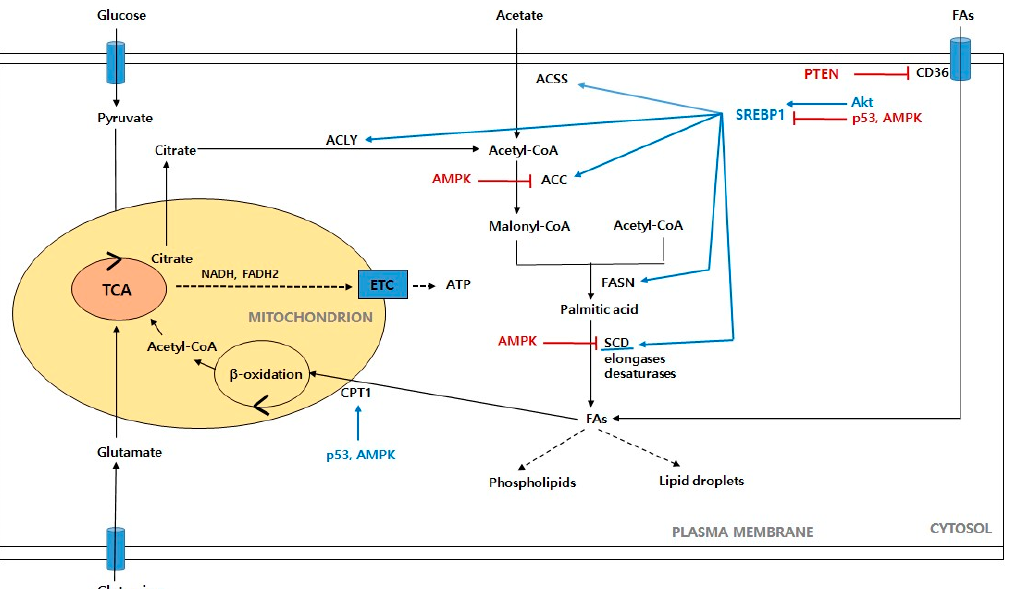
Figure 3. Schematic representation of fatty acid metabolism in cancer cells. Glucose-derived pyruvate enters the mitochondria to form citrate, which then moves to the cytoplasm and contributes to the de novo synthesis of fatty acids. Acetate is also another source of lipogenesis. When cellular fatty acids are in excess, the fatty acids absorbed through CD36 are converted into lipid droplets and are made available when needed. Acetate also provides reducing equivalents, such as NADH and FADH2 through β -oxidation. Finally, ATP is generated from the ETC. Abbreviations: ACSS: acetyl-CoA synthetase; ACLY: ATP citrate lyase; ACC: acetyl-CoA carboxylase; FASN: fatty acid synthase; SCD: stearoyl-CoA desaturase; FAs: fatty acids; CPT1: carnitine palmitoyl transferase 1; ETC: electron transport chain. Akt: protein kinase B; AMPK: AMP-activated protein kinase; PTEN: phosphate and tension homolog; SREBP1: sterol regulatory element-binding